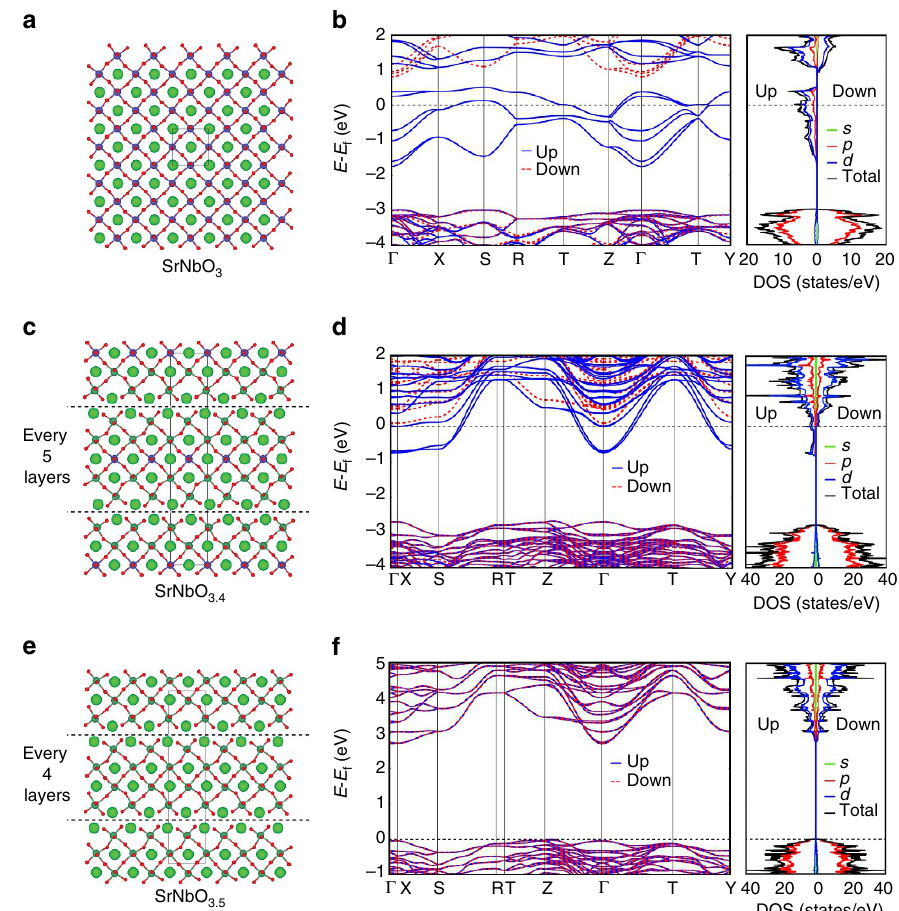
Figure 3 | Crystal structures and energy band structures with its density of state (DOS) of SrNbO (3 þ d ) . ( a ) Distorted perovskite structure of SrNbO 3 . O 2 (cid:2) : small red sphere, Sr 2 þ : large green sphere, Nb 4 þ : small blue sphere. The unit cell is shown with the black solid line. ( b ) Band structure and DOS of SrNbO 3 , showing its metallic behaviour. ( c ) The layered structure of SrNbO 3.4 with extra oxygen layers inserted every five octahedral layers. The dash lines indicate where the extra oxygen layers are. Nb 4 þ (small blue sphere) and Nb 5 þ (small green sphere) are given different colours to show charge ordering in this composition. ( d ) Band structure and DOS of SrNbO 3.4 , with significantly reduced carriers at the Fermi level. ( e ) The layered structure of SrNbO 3.5 , with an extra oxygen layer inserted every four octahedral layers. ( f ) Band structure and DOS of SrNbO 3.5 , showing its insulating behaviour. The calculation method is using DFT þ U ( U ¼